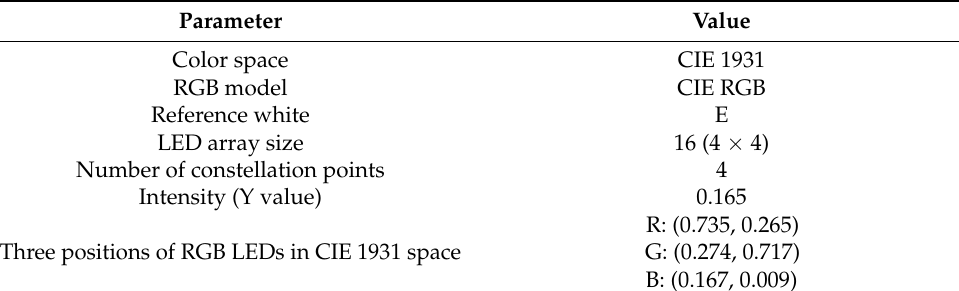
Table 3. GCM information for simulations.